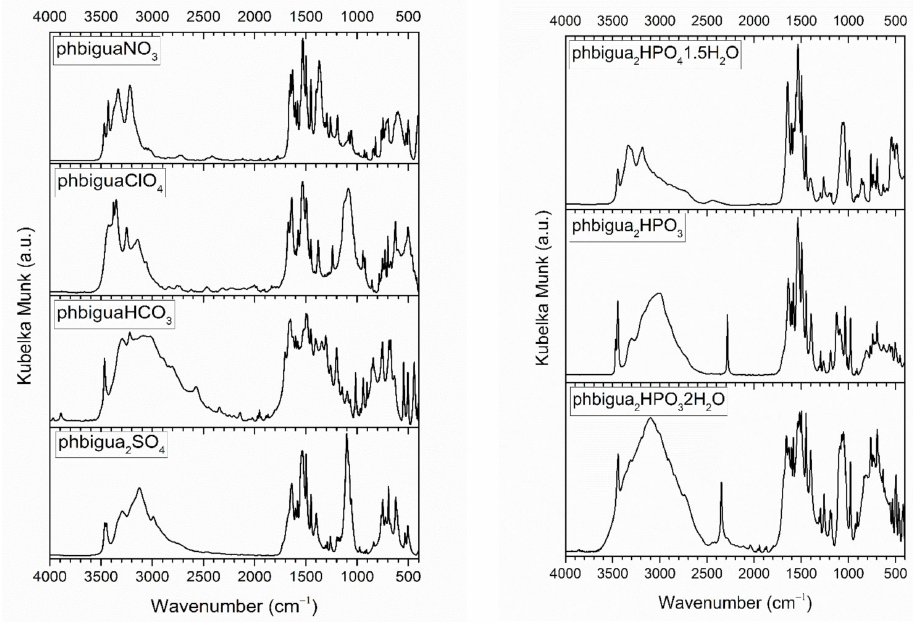
Figure 9. DRIFTS spectra of N -phenylbiguanidium(1+)